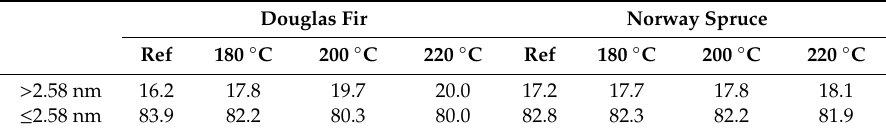
Table 7. The proportion of bound water sites and small voids in swollen cell walls of Douglas fir and Norway spruce after TM (unit: